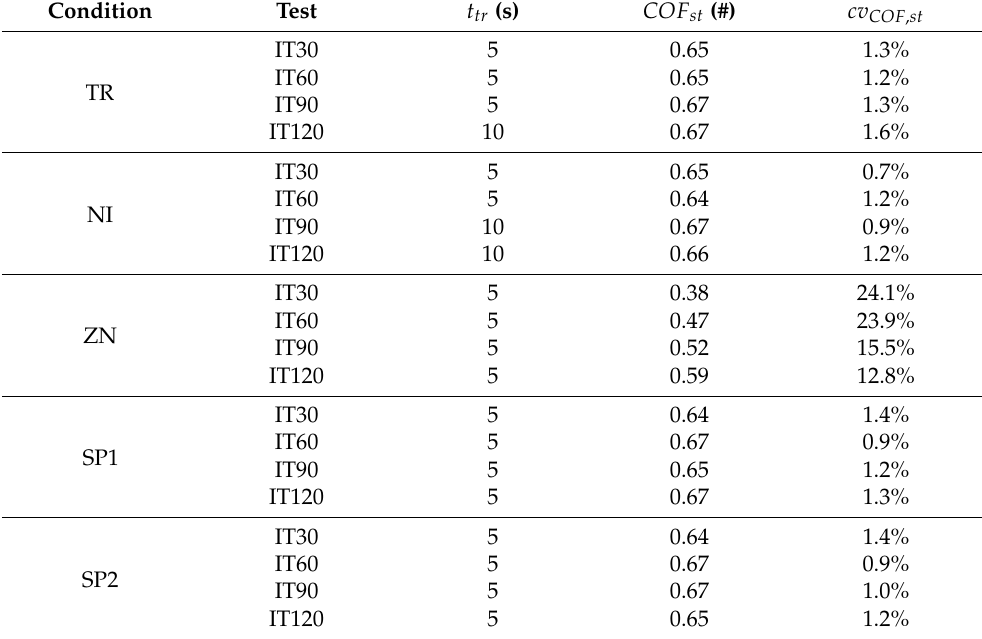
Table 8. Variation of t tr , COF st , and of cv COF at 2 Hz sliding